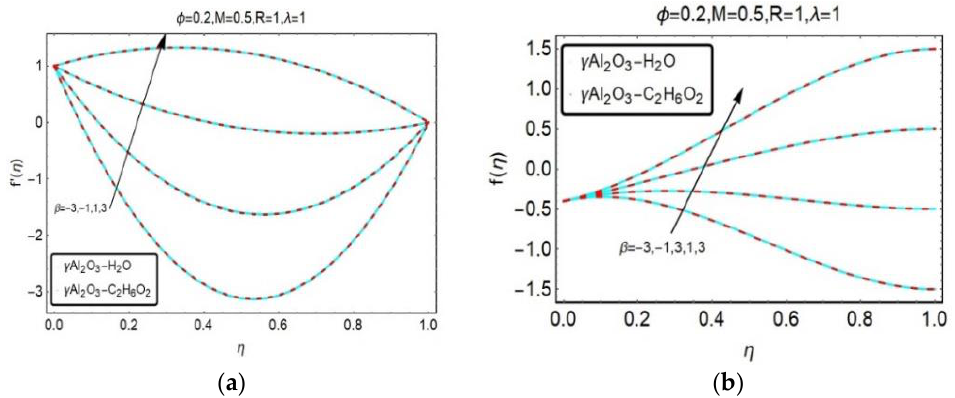
Figure 8. Influence of 𝛽 on 𝑓′(𝜂) for (a) 𝑆 > 0 and (b) 𝑆 < 0 .